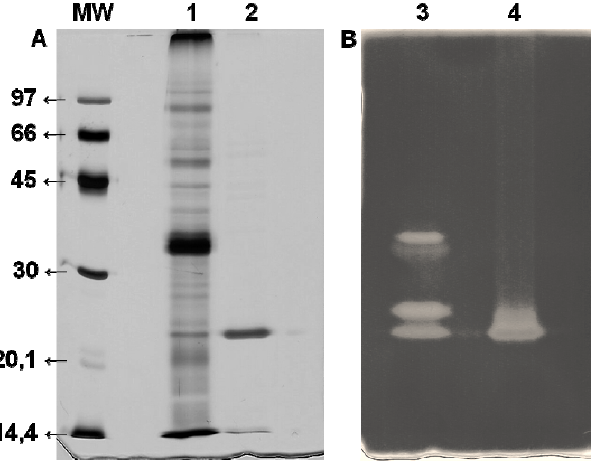
Figure 2. SDS-PAGE (12%) of purified Xyl-O1. The gel was stained with ( A ) silver nitrate or ( B ) 0.1% Congo red. MW—molecular weight marker (phosphorylase b (97 kDa), albumin (66 kDa), ovalbumin (45 kDa), carbonic anhydrase (30 kDa), trypsin inhibitor (20.1 kDa), and α -lactalbumin (14.4 kDa)); Lane 1—FCS from Aspergillus oryzae (10